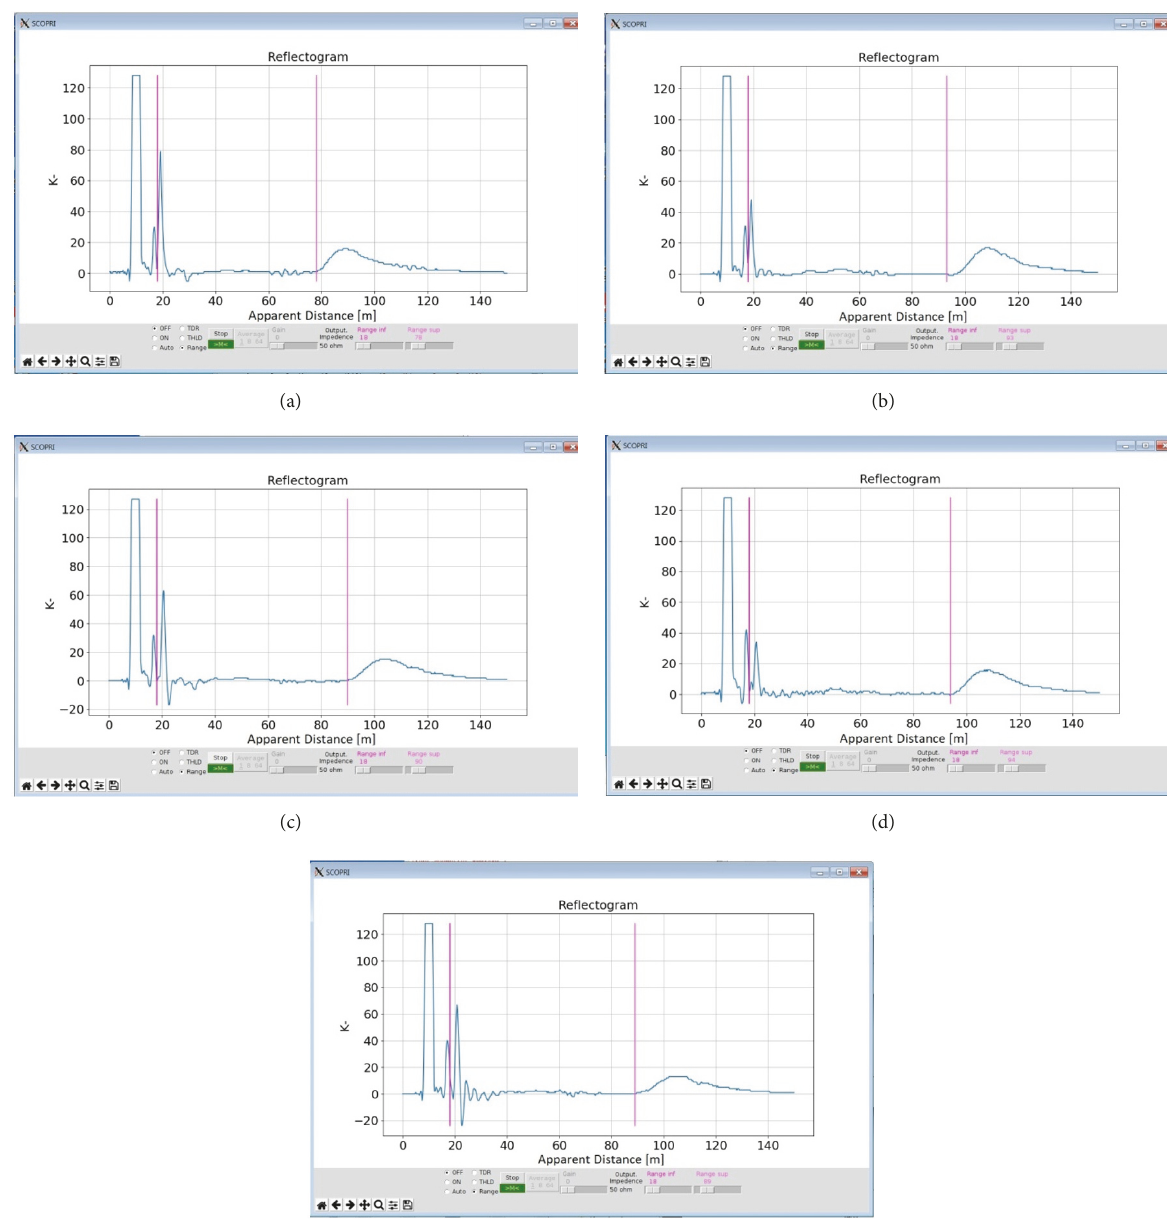
Figure 6: Experiment #2: comparison of the reflectogram acquired from SE 3 during the observation period: (a) day #1; (b) day #14; (c) day #20; (d) day #21; (e) day #24. The shift of the abscissa corresponding to the end of the SE indicates a different amount of soil water content.